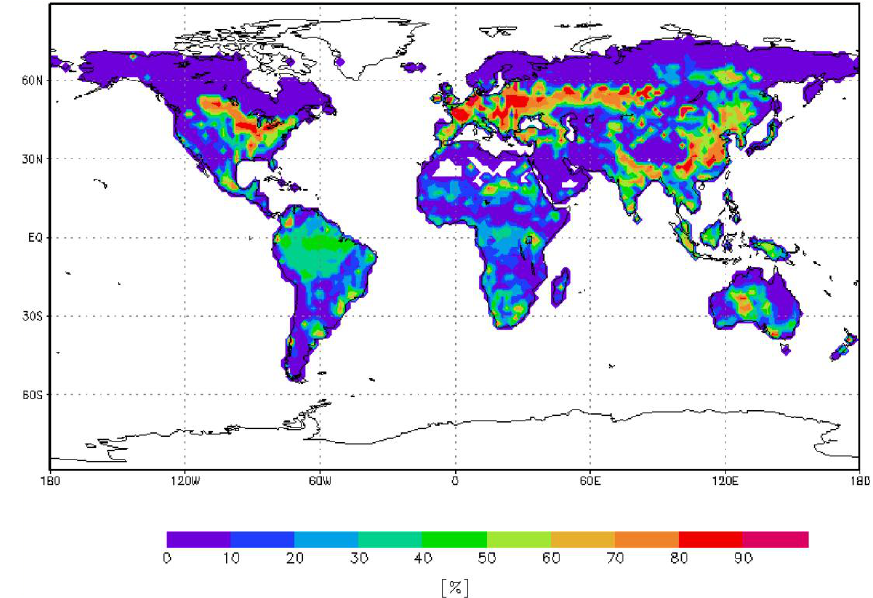
Fig. 6. Uncertainty reduction in NEP per grid cell, for a network consisting of a single flux site (site 1731-9 in Table 4).